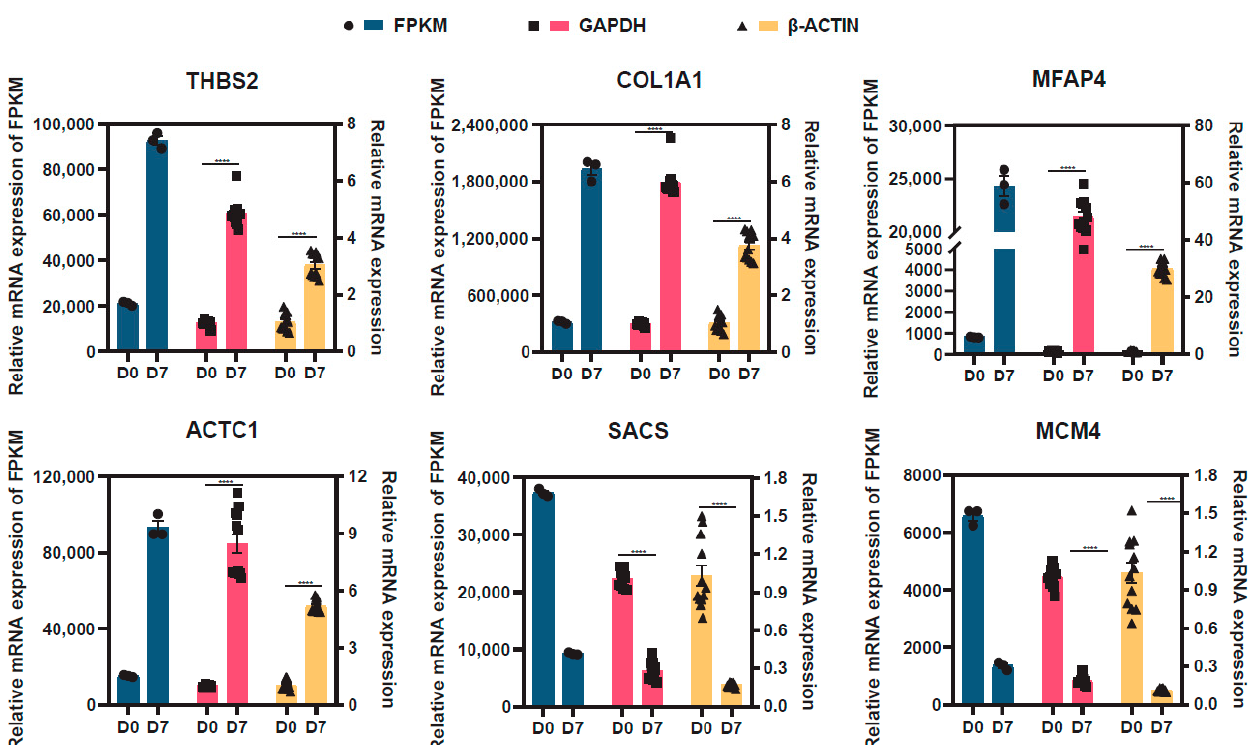
Figure 4. RT-qPCR validation of six differentially expressed genes. The left Y -axis displays the FPKM derived from the RNA-Seq, while the data from RT-qPCR are shown on the Y -axis on the right. Note: The data are represented as the means ± SED; blue represents the FPKM value of RNA-Seq, pink represents the RT-qPCR with GAPDH as the internal reference gene, and yellow represents the RT-qPCR with β - ACTIN as the internal reference gene; **** means p < 0.001.